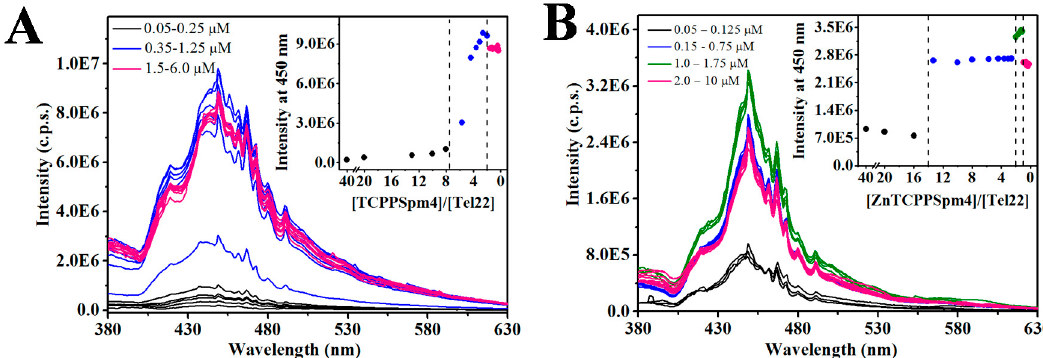
Figure 4. Representative RLS titration of 2.0 µ M ( A ) TCPPSpm4 and ( B ) ZnTCPPSpm4 with 500 µ M Tel22 at 25 ◦ C. The amounts of Tel22 added are specified in the legend. Inset reports RLS intensity at 450 nm vs [porphyrin]/[Tel22] ratio. Note, the scale in the inset is inverted to follow the progress of the titration which starts with the solution of porphyrin and proceeds toward lower [porphyrin]/[Tel22] ratios.